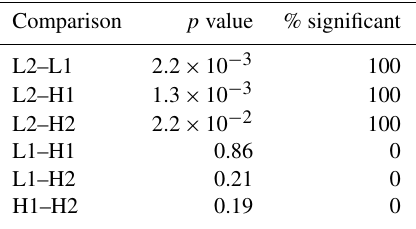
Table 8. The mean p value and the percent of data that are statisti- cally significant (for the first 60 PCF values) between PCF functions provided in Fig.